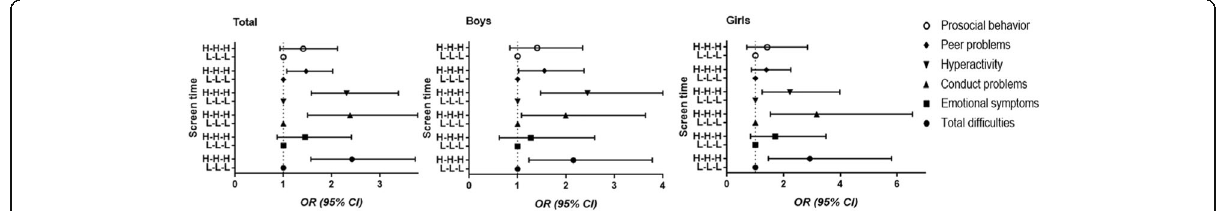
Fig. 2 Adjusted odds ratios (95% confidence intervals) between sustained ST and emotional and behavioral problems (H-H-H, continuous high ST; L-L-L, continuous low